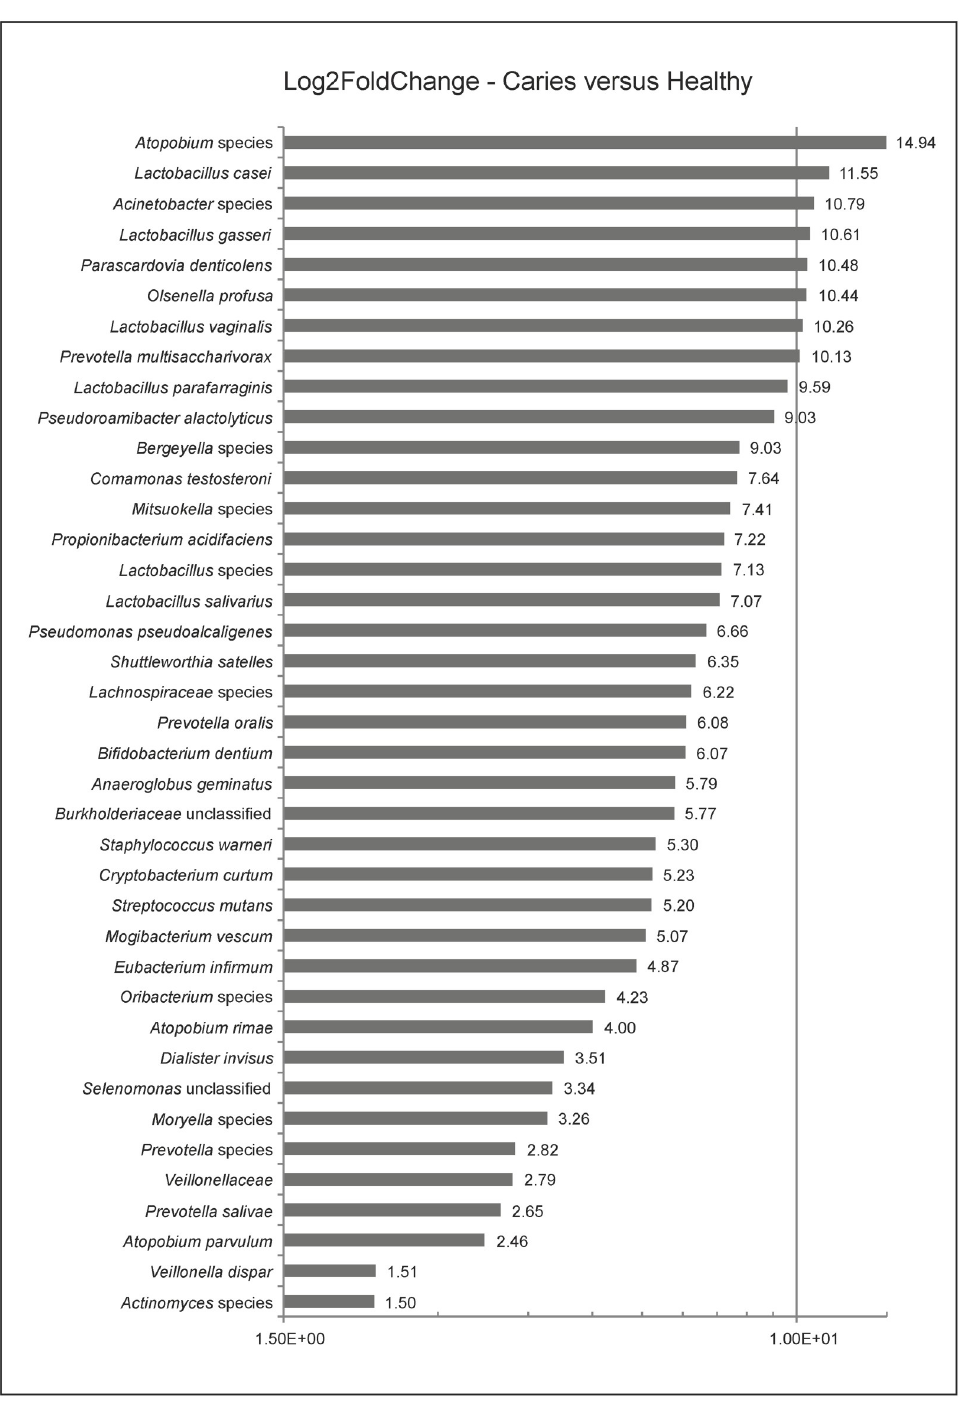
PLOS ONE | https://doi.org/10.1371/journal.pone.0219714 July 31,